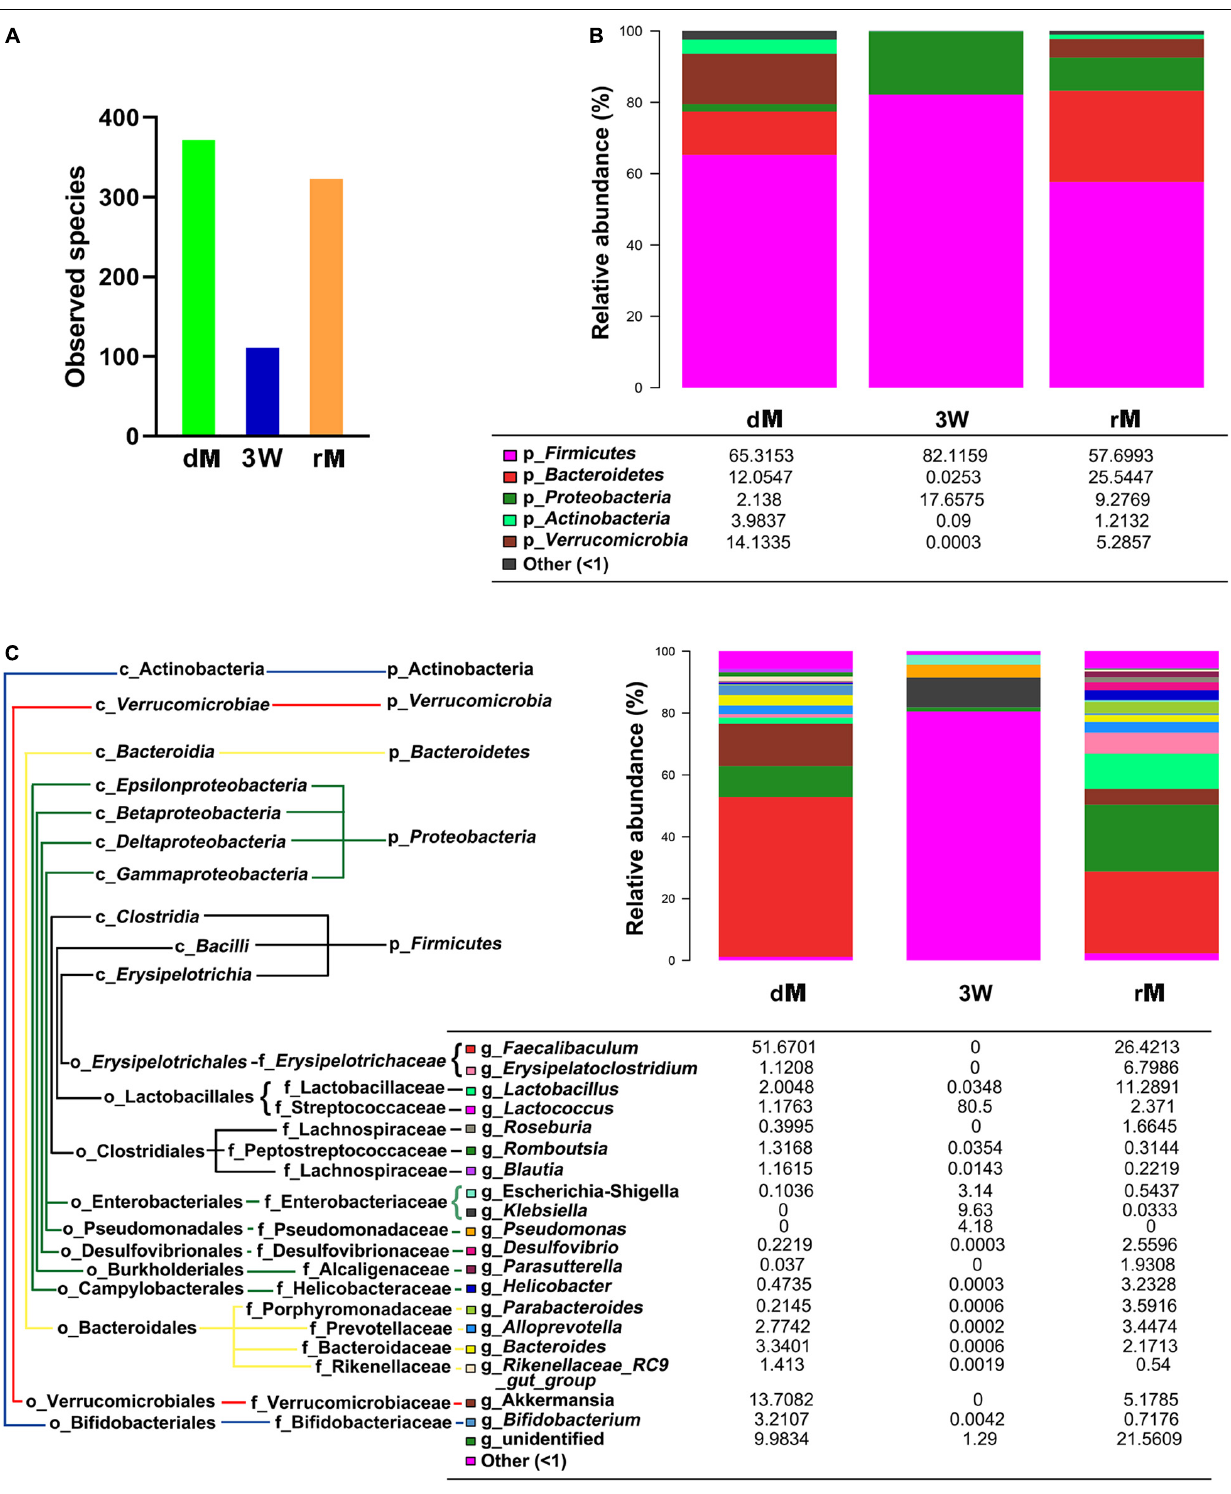
Frontiers in Nutrition |